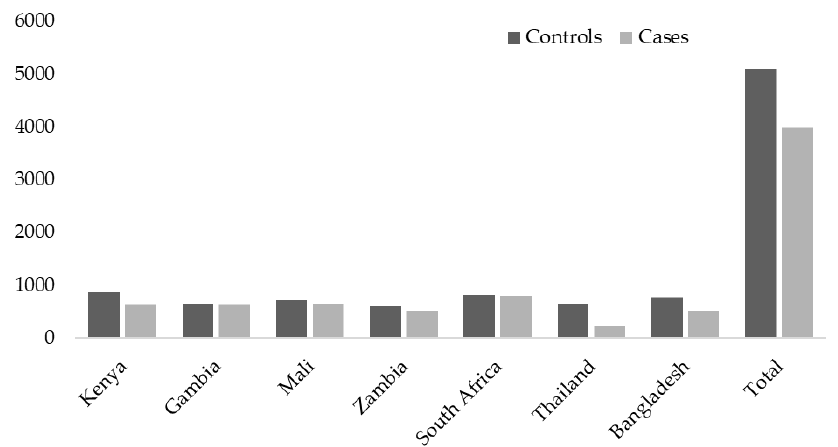
Figure 1. The number of cases and controls enrolled per country and overall.